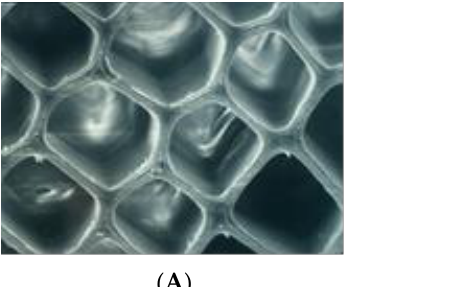
Figure 7. Loss of surface fibers due to UV degradation of lignin.